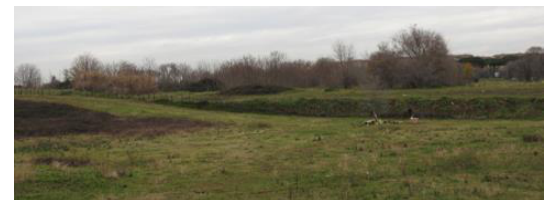
Figure 3. Medium stemmed bushes covering, slopes, sink-holes and depressions filled with soil and gravel